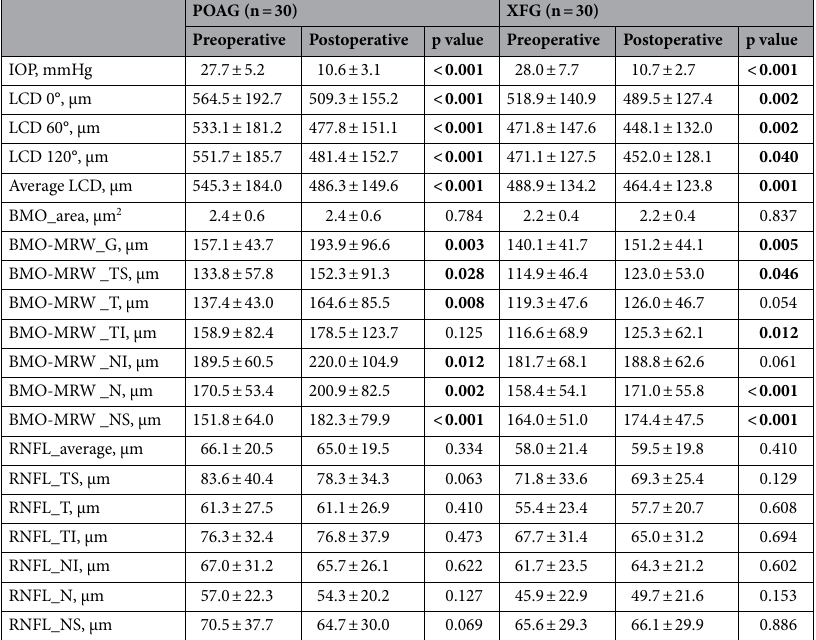
Table 2. Intraocular pressure, lamina cribrosa depth, Bruch’s membrane opening minimum rim width, and retinal nerve fiber layer thickness at preoperative and postoperative optical coherence